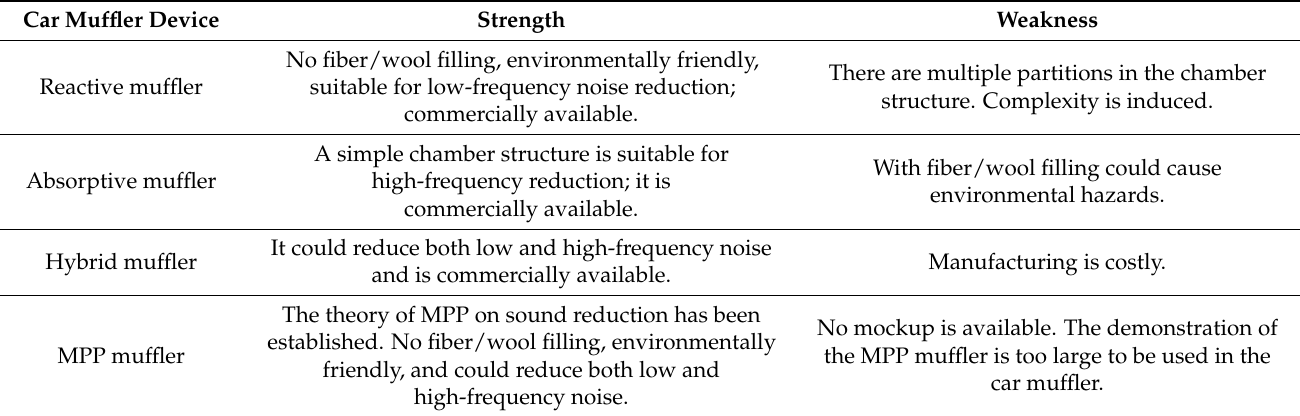
Table 1. Comparison among car muffler